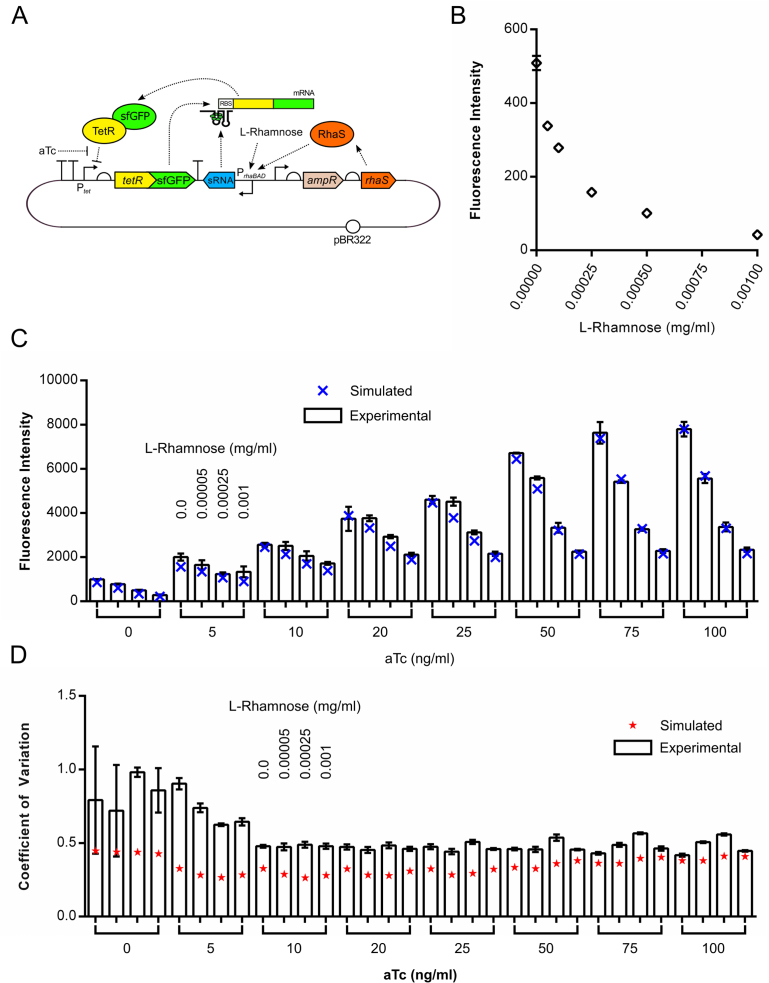
Testing the tunability of the sRNA-tuned autorepressor plasmid pCK221. A) Schematic diagram of plasmid pCK221. (B) Testing the tunability of sRNA translation inhibition with increasing concentrations of L-rhamnose. E. coli strain JW3876 was transformed with pCK221, cultured at 37°C in EZ rich defined medium supplemented with glycerol and increasing concentrations of l-rhamnose and GFP fluorescence measured at late exponential phase (5 h) by flow cytometry. (C) Testing the ability to fine-tune the coarse aTc input–output dial with the inducible expression of the sRNA. E. coli strain JW3876 was transformed with pCK221, cultured at 37°C in EZ rich defined medium supplemented with glycerol and increasing concentrations of l-rhamnose and aTc and GFP fluorescence measured at late exponential phase (5 h) by flow cytometry (white columns). Simulated steady-state output is overlayed to show model fit (blue X). (D) Experimentally-obtained coefficients of variation around the TetR-sfGFP mean when output is tuned using both l-rhamnose and aTc (white columns) with predicted coefficients of variation overlayed (red stars). Fluorescence intensity represents the geometric mean of fluorescence. Error bars shown represent the standard deviation of three independent biological replicates. Statistical significance was determined using a one-way ANOVA, followed by a Tukey's multiple comparison test assuming unequal variance.